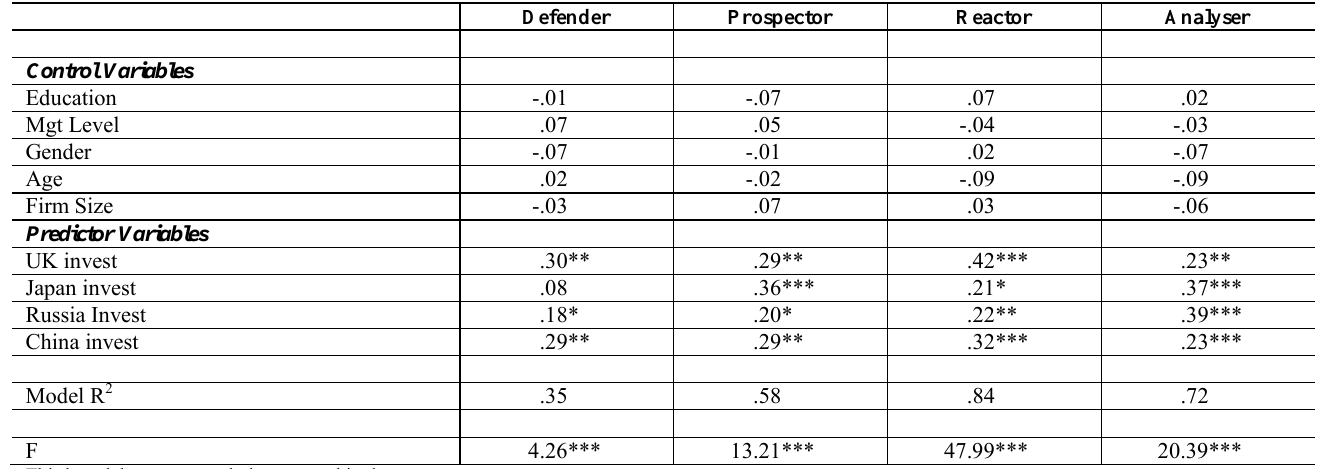
Table 3: Regression results: Dependent variables: Strategic orientations Defender Prospector Reactor